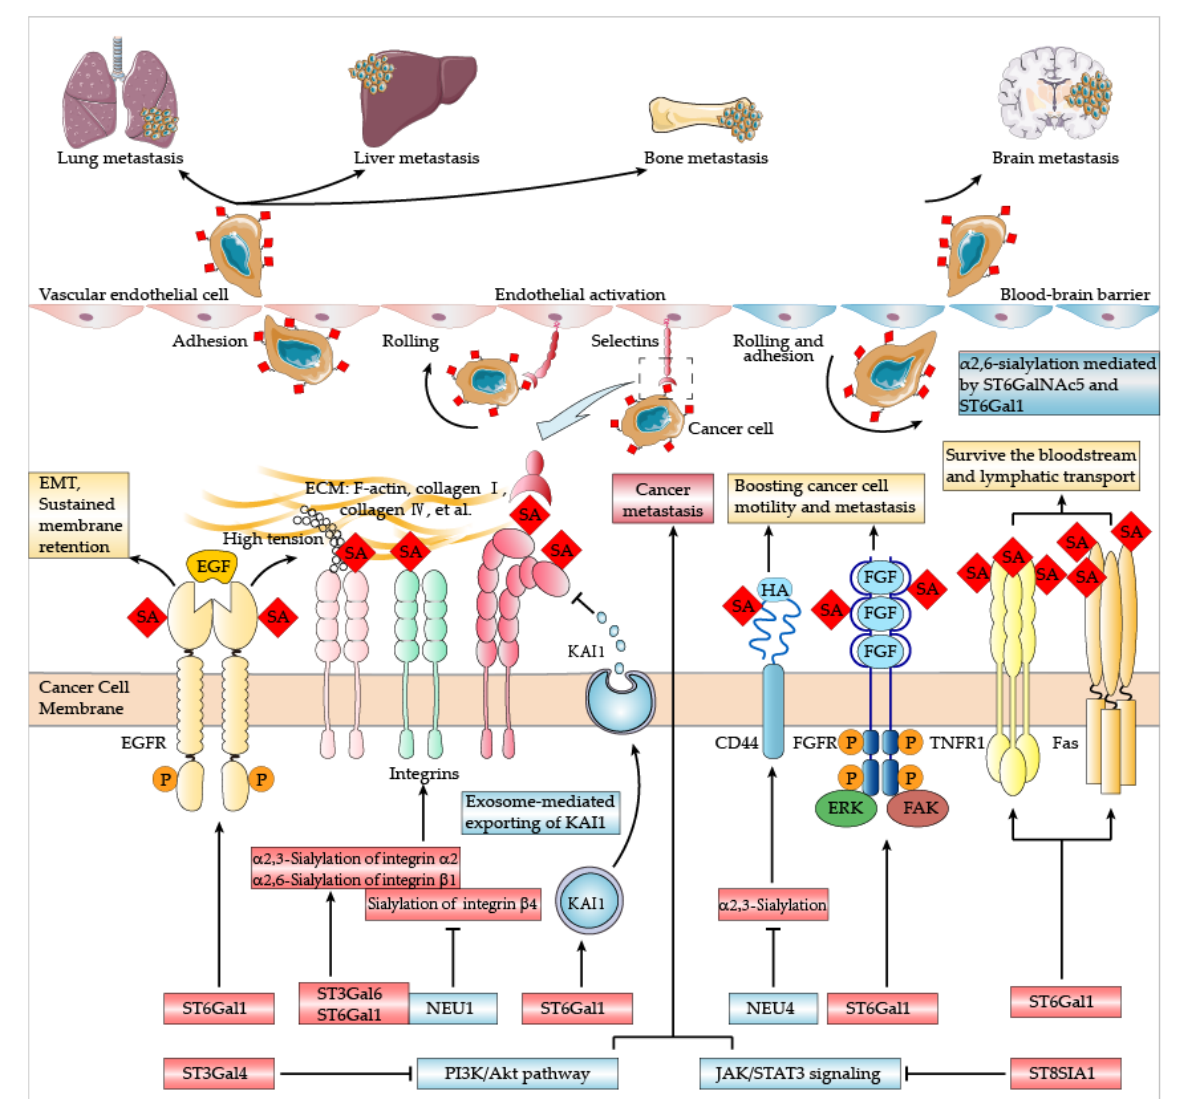
Figure 4. The impact of sialylation on tumor metastasis. α 2,6-Sialylation of EGFR sustains its membrane retention and regulates the EMT of cancer cells, enhancing integrin tension, focal adhesion, and cell motility [43–45]. α 2,3-Sialylation and α 2,6-sialylation of integrins enhance their adherence to ECM [46,57,58 ]. α2,3 -Sialylation of CD44 improves adhesion to HA, hence boosting cancer cell motility and metastasis [49]. α2,6 -Sialylation of FGFR increases the ERK1/2-FAK signaling to promote the migration of cancer cells [50]. Furthermore, α2 -6-sialylation of Fas and TNFR1 inhibits apoptotic signaling and helps the survival of bloodstream and lymphatic transport, consequently ensuring the formation of the secondary tumor site [53]. However, some labs have found that STs or sialylations play some opposite roles in cancer invasion and spread. For example, ST6Gal1 promotes the exosome-mediated export of the metastasis suppressor KAI1, which inhibits integrin signaling [59]. ST3Gal4 and ST8SIA1 are also reported to suppress the metastasis of cancer cells by inhibiting PI3K/Akt pathway and the phosphorylation of JAK2/STAT3, respectively [60,61]. SA: sialic acid, HA: hyaluronic acid, EGFR: epidermal growth factor receptor, EGF: epidermal growth factor, EMT: epithelial-to-mesenchymal transition, FGFR: fibroblast growth factor receptor, FGF: fibroblast growth factor, P: phosphorylation, TNFR1: tumor necrosis factor receptor 1, ERK: extracellular regulated protein kinases, FAK: focal adhesion kinase, ECM: extracellular matrix, KAI1: Kang-Ai 1, NEU: neuraminidase, PI3K/Akt: phosphoinositide-3 kinase/serine/threonine protein kinase B, JAK2/STAT3: Janus kinase 2/signal transducer and activator of transcription 3.